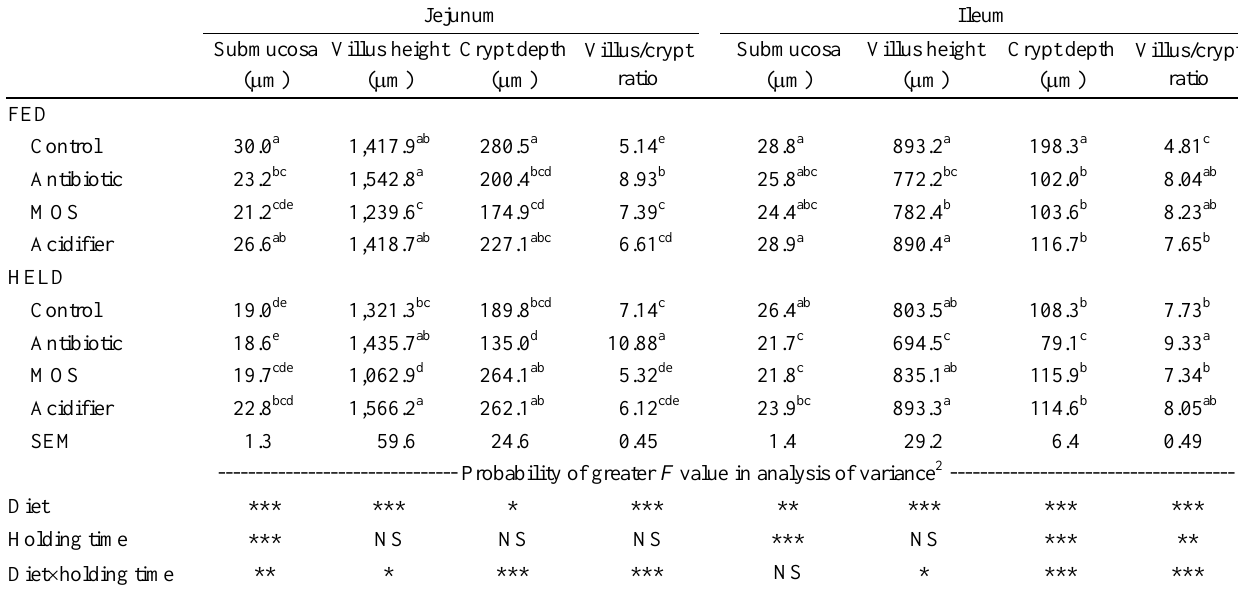
Table 7. Effects of post hatch holding time and dietary supplements on the morphology of small intestine at d 21